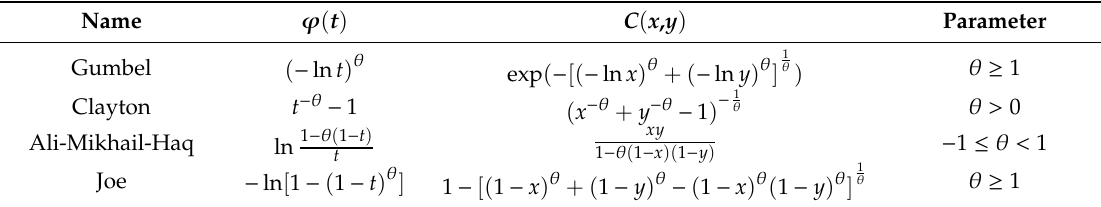
Table 1. In ref. [24] Archimedean Copulas.